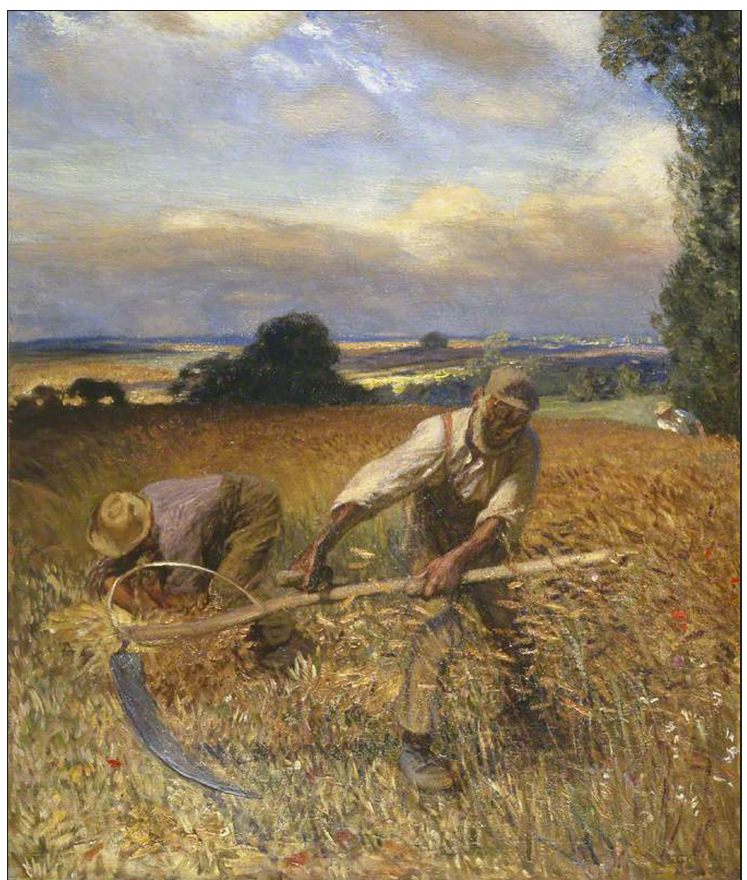
Fig. 9 : George Clausen, The Old Reaper , 1909, oil on canvas, 76.7 × 63.7 cm, Manchester Art have seductive charms of atmosphere, impressionist brushstrokes, and bright colour that were lacking in the more documentary portrait of the woodman. The relationship between trees and men is implicit in these paintings: the ancient barn is made entirely of wood, the reaper grasps the wooden handles of a scythe. The old barns with their doors large enough to take loaded wagons were becoming obsolete at this time, as threshing machines took over the work that would previously have been done by hand during the winter, and many were pulled down to make way for more modern buildings. Scything, too, was becoming a rarer sight, generally used only for the headland of a field, where overhanging trees or damp patches impeded the progress of the reaping machine. Around this time a rural commentator remarked, ‘the chances of watching the survival of a vanishing art, the height of an accumulated tradition of skill, that dies without an heir tomorrow, grows less and less with every haytime that comes around’ (McConkey, p. 150). The old reaper looks barely strong enough to hold the heavy scythe;